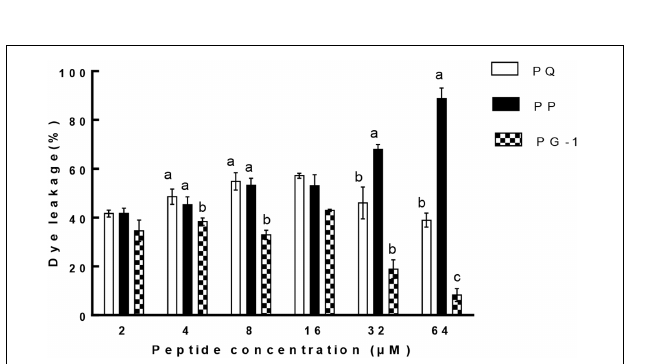
form a more ideal amphiphilic α -helical structure than Qna.